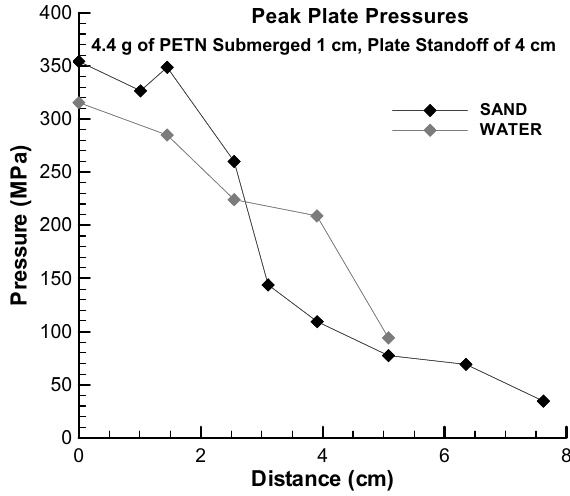
Fig. 1. Water and saturated sand pressure peaks.